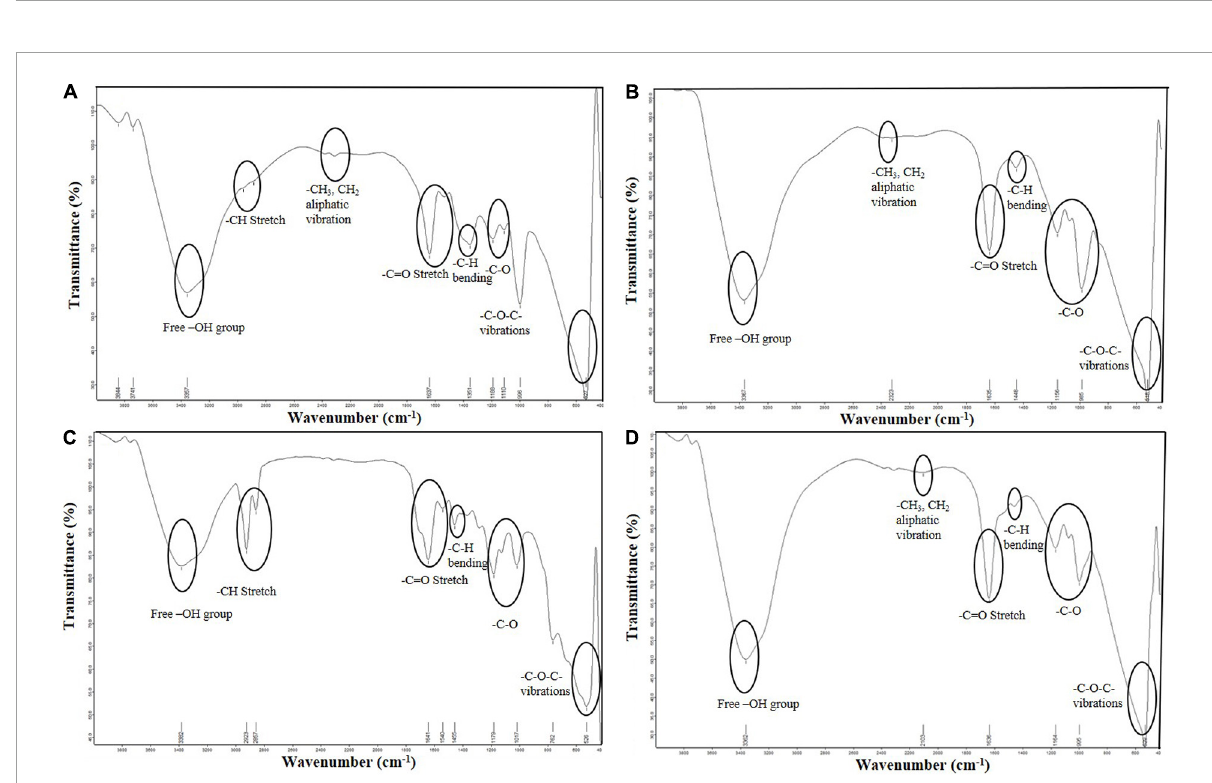
FIGURE8 ATR-FTIR-based structural characterization of the biosurfactant produced (A) MAPB-2 (B) MAPB-6 (C) MAPB-9, and (D)